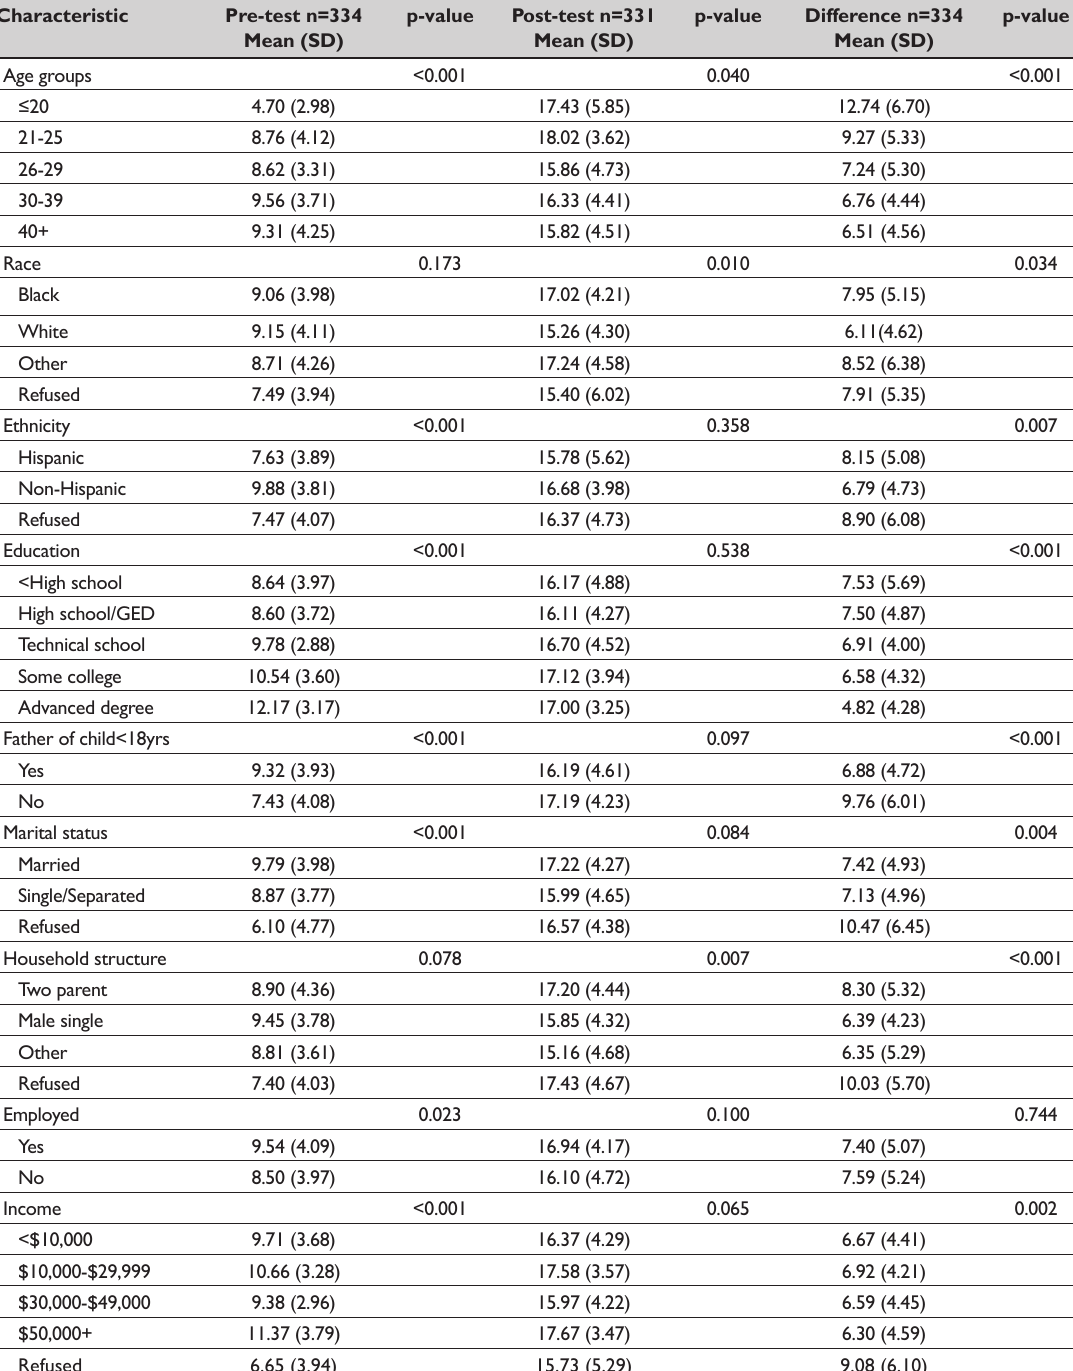
Table 2: Pre- and post-test results according to participant characteristics